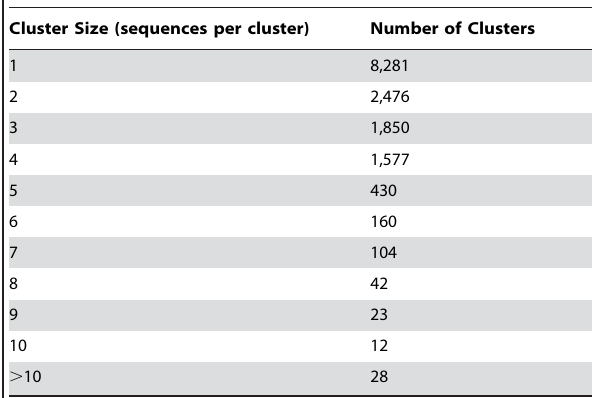
Table 5. Number of all sequence clusters and clusters supported by MS data, EST data, and MS and EST data,